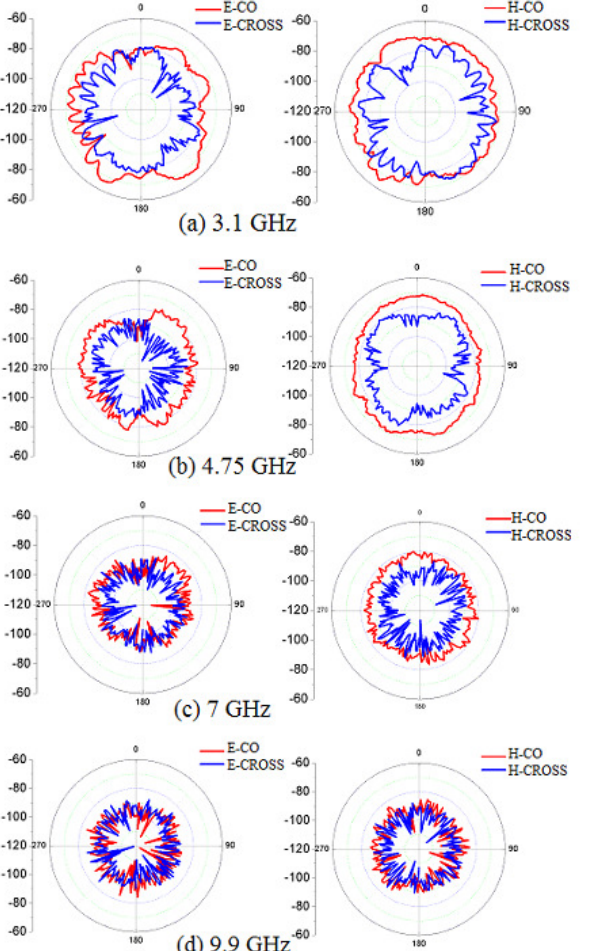
Figure 11: Measured E- and H-plane (co- and cross-pole) radiation pattern for hammer-shaped Antenna-D at various resonant